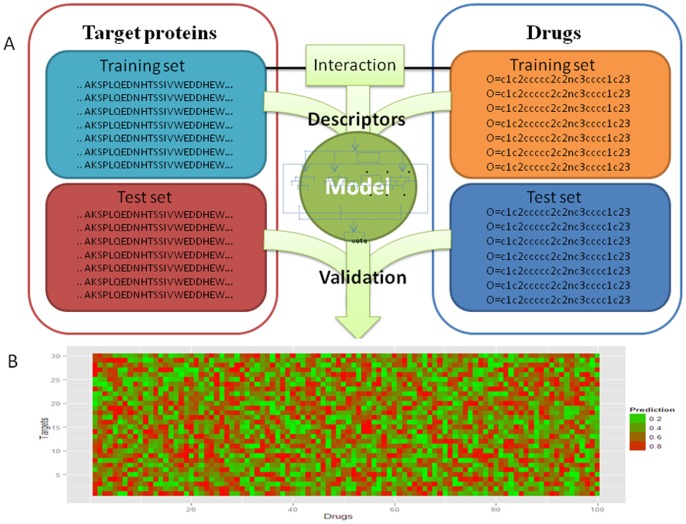
Outline of our methodology.(A) Interaction features are calculated by combing the fingerprint descriptors from drugs and the CTD and amino acid composition descriptors from protein sequences. These feature vectors are used to find the optimal RF parameters which most accurately separate the positive and negative training sets. The independent validation sets are used for further validation for the RF model. (B) Once the RF model is constructed, we can predict new unknown drug-target associations or screen all cross-linking associations.